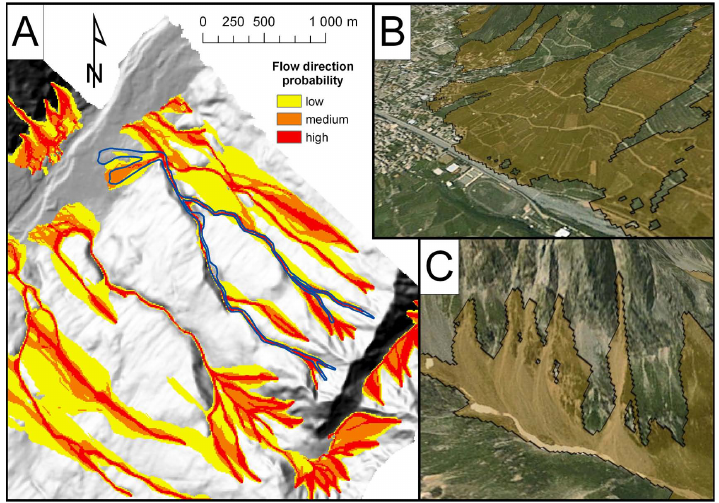
Fig. 7. Examples showing the runout model calibration (yellow polygons). A – debris flow that affected in 1987 Tiolo (Grosio municipality) delimited by the blue polygon (GeoIFFI, 2006); B – 3-D view of the alluvial fan near Tirano with calibrated runout represented as yellow polygon (visualised in Google Earth); C – 3-D view of debris flows in the southern part of the study area with calibrated runout represented as yellow polygon (visualised in Google Earth). See Fig. 1 for location.